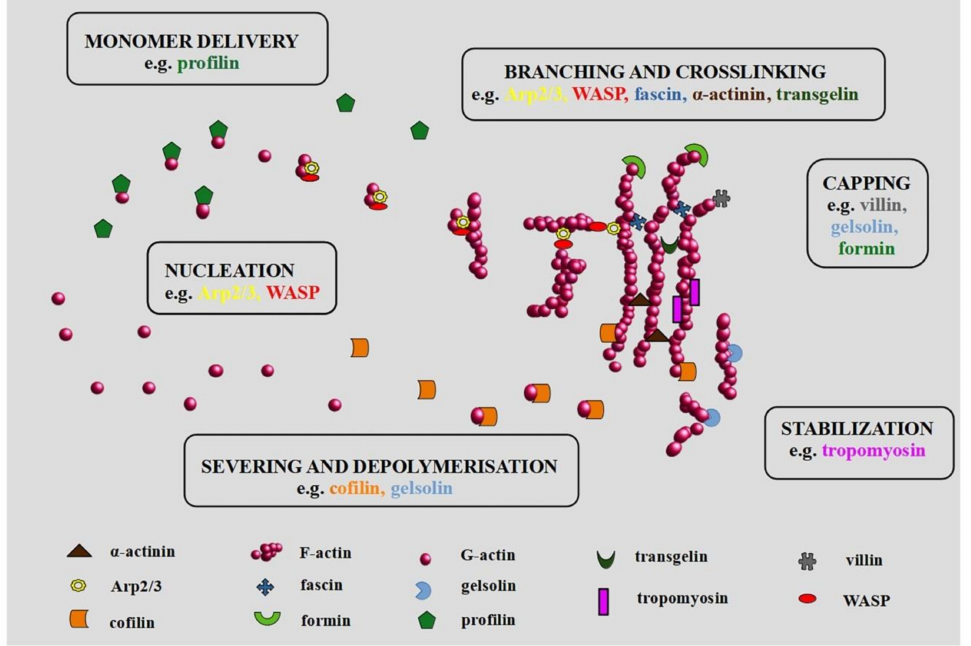
Figure 1. Actin-binding proteins (ABPs) in organization of actin network. Modified on the basis of dos Remedios et al. (2003) and Winder and Ayscough (2005)